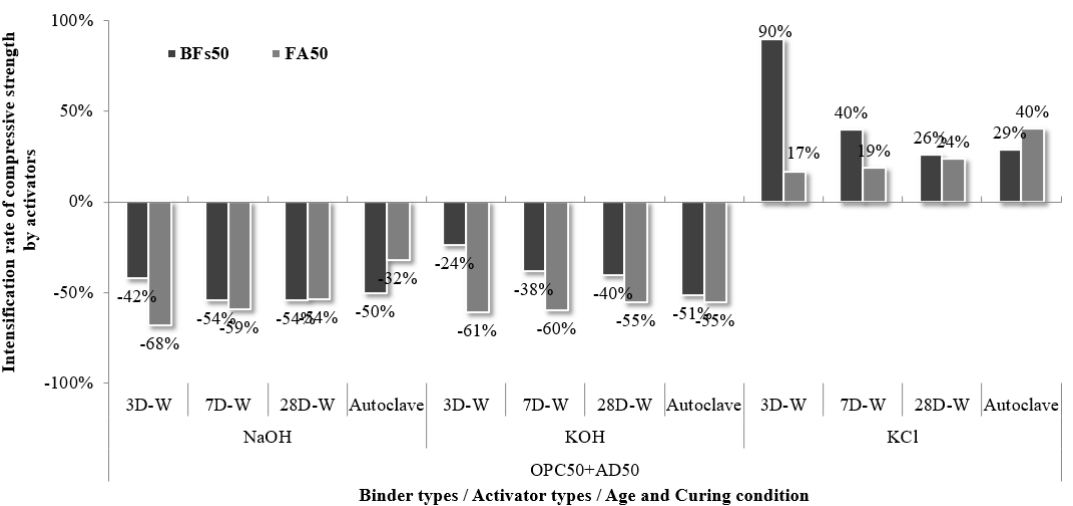
Figure 6. Compressive strength intensification rate of the KCl separated from CBD, NaOH, and KOH activators in the 50% mineral admixture (BFS or FA) and 50% OPC mortar